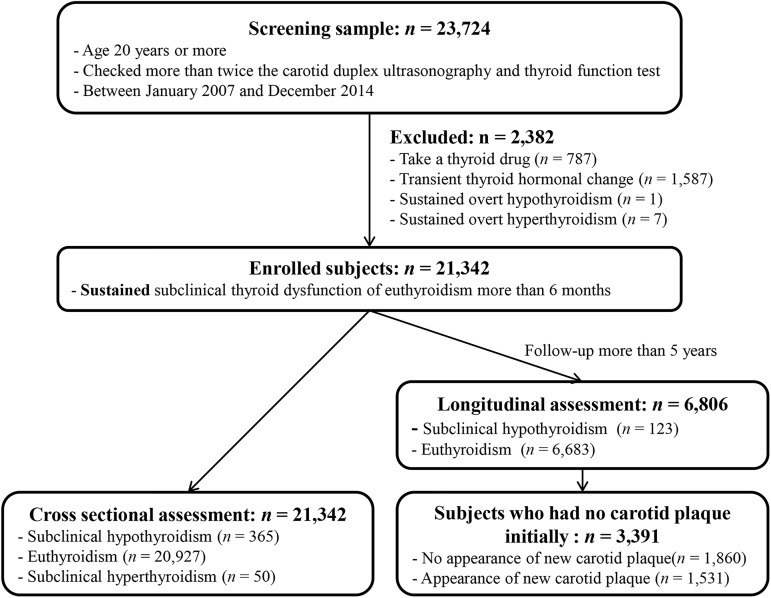
Flow diagram of study subjects.Cross-sectional assessment of carotid plaques was performed for the 21,342 enrolled subjects; of these, 3,391 subjects who showed sustained thyroid functional status with at least 5 years of follow-up were screened for longitudinal assessment of new carotid plaques.